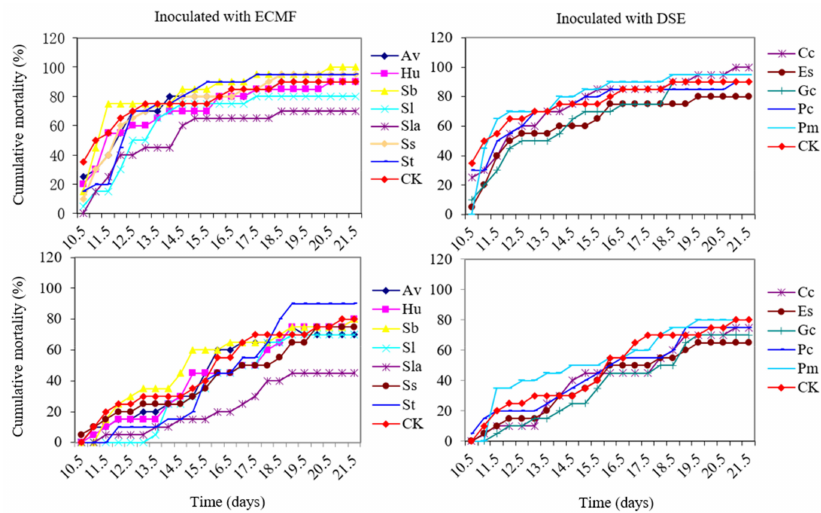
Figure 4. Cumulative morbidity and mortality of ECMF and DSE P. tabulaeformis seedlings after 10 days of inoculated with PWN. Av, Hu, Sb, Sl, Sla, Ss, and St represent P. tabulaeformis seedlings were inoculated with ECMF of A. vaginata , H. utriformis , S. bovinus , S. lactifluus , S. laricinus , Schizophyllum sp., and S. tomentosus , respectively; Cc, Es, Gc, Pc, and Pm represent the P. tabulaeformis seedlings were inoculated with DSE of C. cladosporioides , E. salmonis , G. cylindrosporus , P. chrysanthemicola , and P. mustea , respectively; and CK as the control